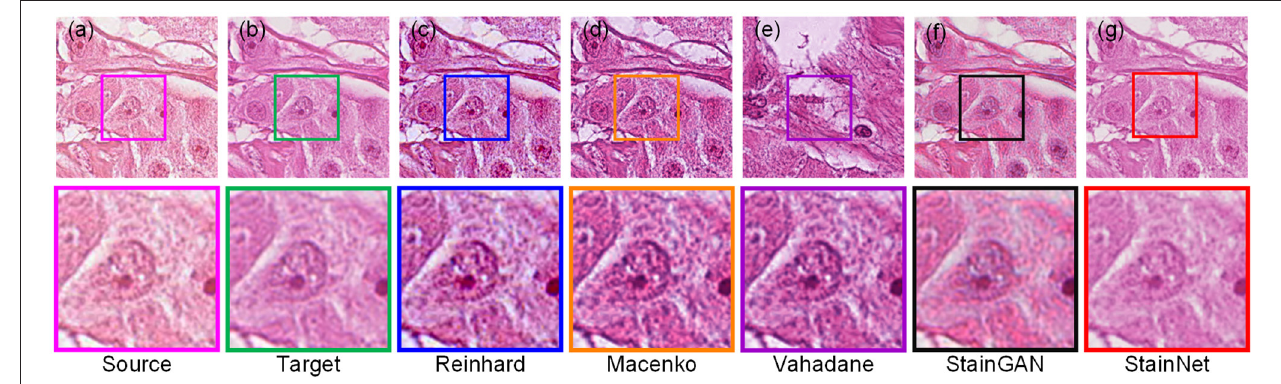
FIGURE 5 | Visual comparison of different normalization methods on the aligned histopathology dataset. Source image (a) , target image (b) , and normalized image by Reinhard (c) , Macenko (d) , Vahadane (e) , StainGAN (f) , and StainNet (g) are listed.